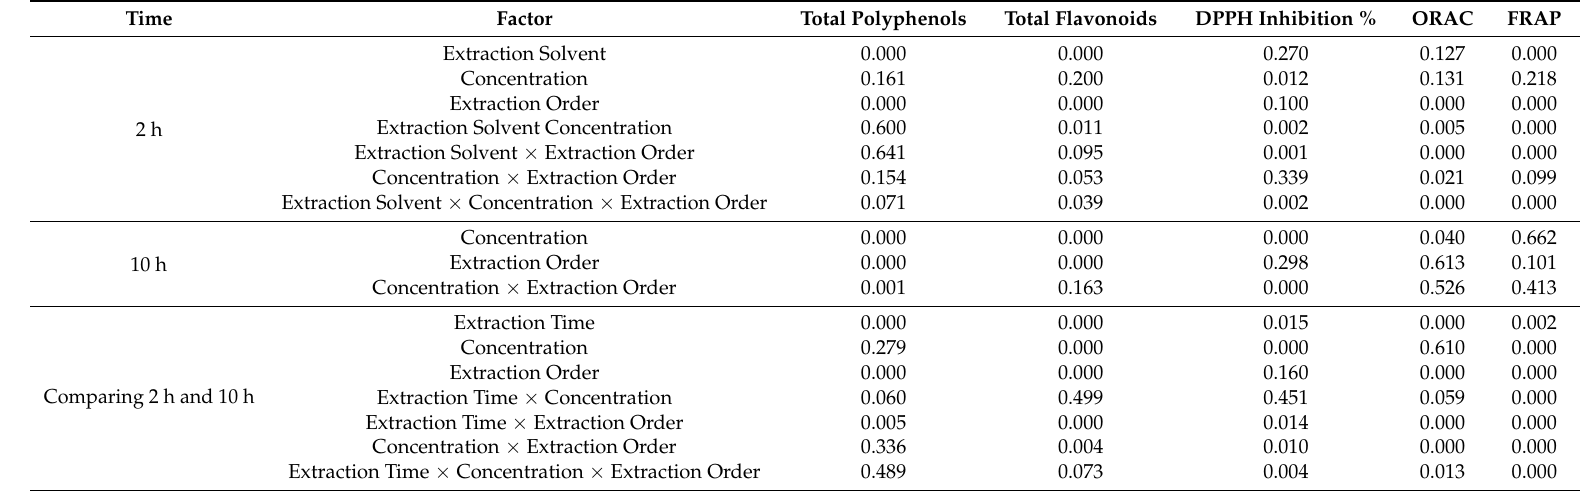
Table 3. p -Values found for the effects of conventional extraction parameters on the total polyphenol content, total flavonoid content, and antioxidant activity (DPPH, ORAC and FRAP) of extracts obtained from AR ( p < 0.05 indicates